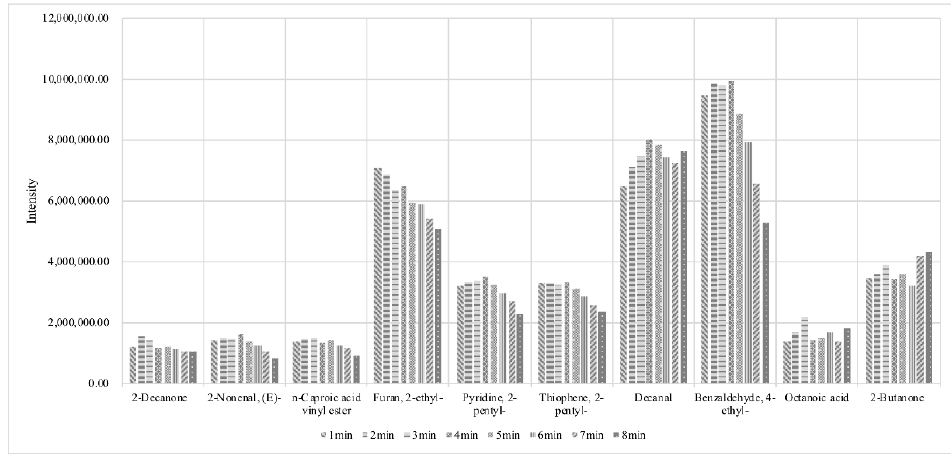
Figure 3. The influence of desorbing time on some typical volatiles.